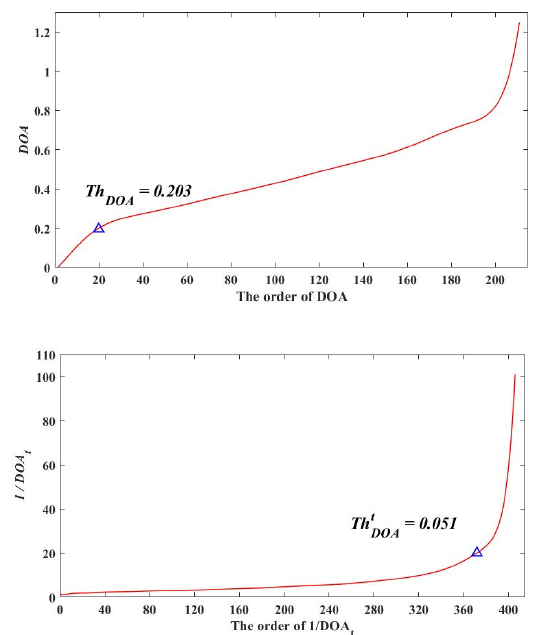
Figure 6. The calculation of linking thresholds. The triangle symbol is located at the inflection point of the curve, and the equation represents the value of the corresponding variable at the inflection point.